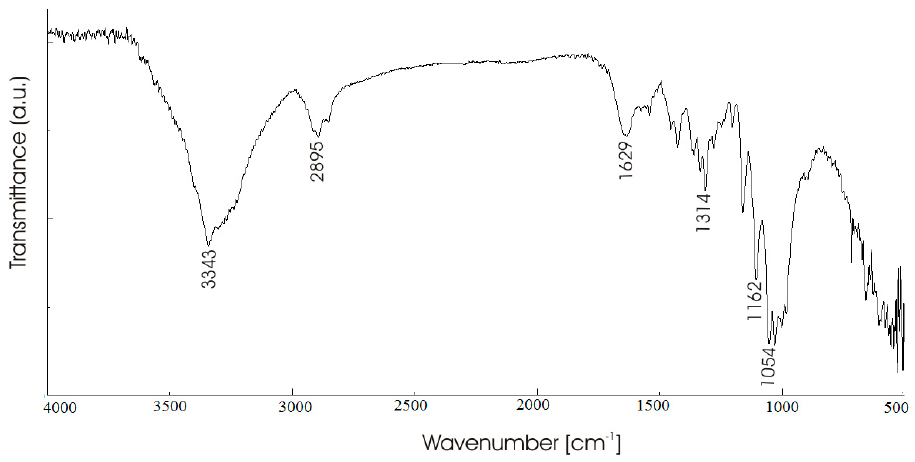
Figure 5. FTIR spectrum of BC used for composite membranes synthesis.